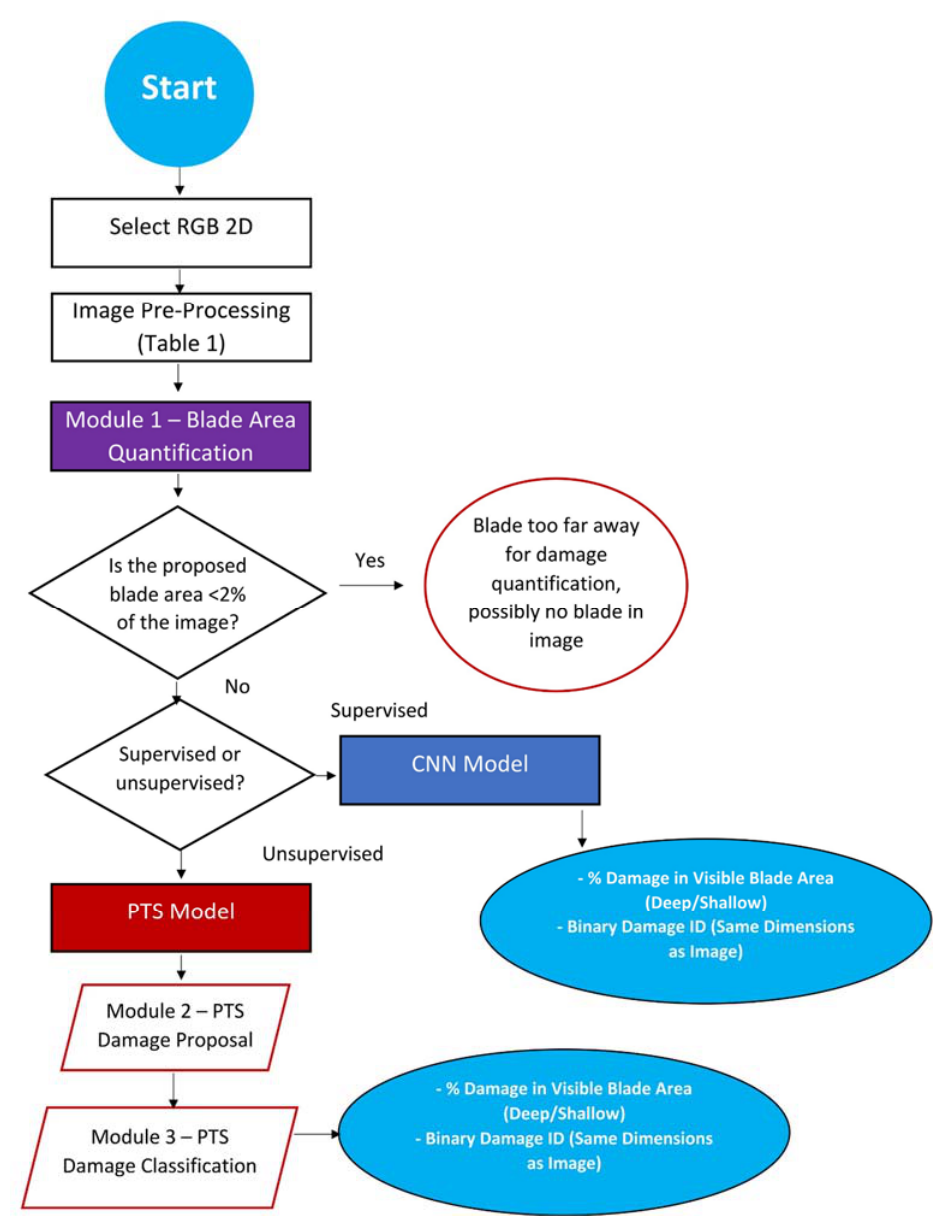
Figure 3. Flowchart of entire LEE quantification model development and testing process showing the common aspects; image preprocessing and blade area quantification (purple) and the subsequent separation into the unsupervised (PTS—red)/supervised (CNN—blue) methods.